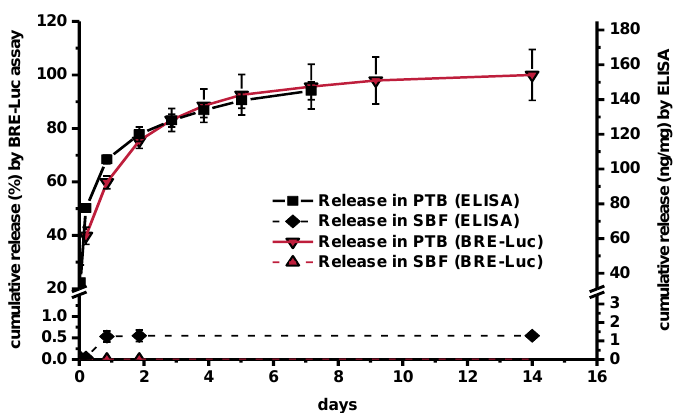
Figure 3. BMP-2 release from identical fiber mats in PTB and SBF (BRE-Luc assay, ELISA, n = 3, error bars indicate SD between individual release experiments).